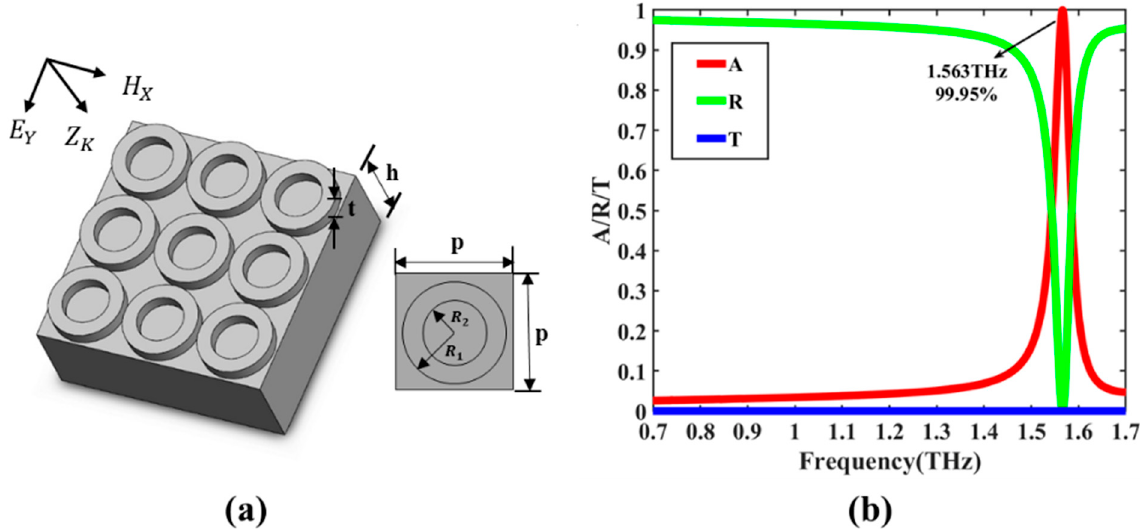
Figure 1. ( a ) Structural diagram of the terahertz absorber made of stainless steel. ( b ) The reflection, transmission, and absorption spectrum of the stainless steel absorber.